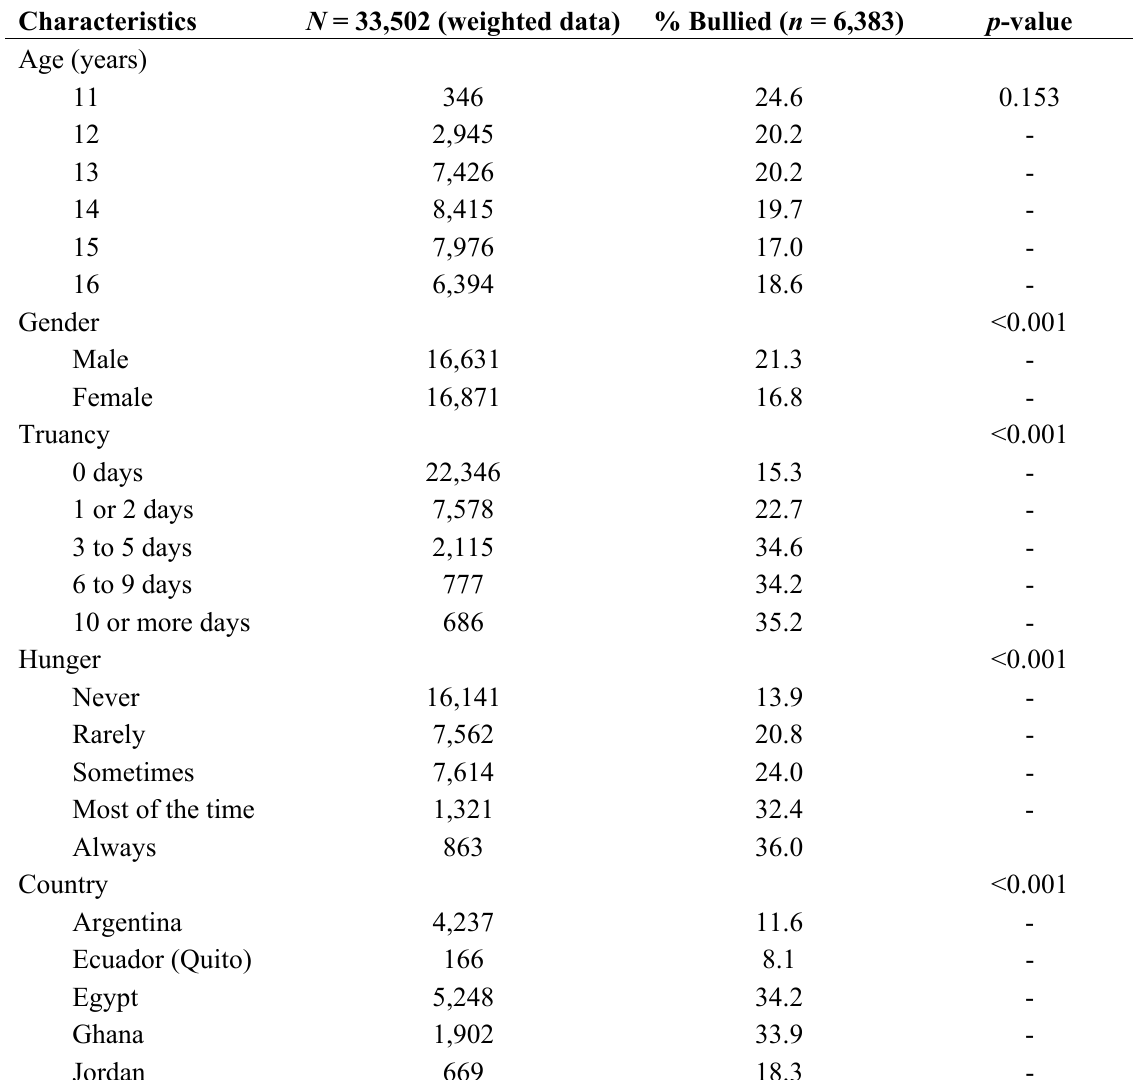
Table 1. Bivariate analyses of bullied adolescents among a sample of low- and middle-income countries